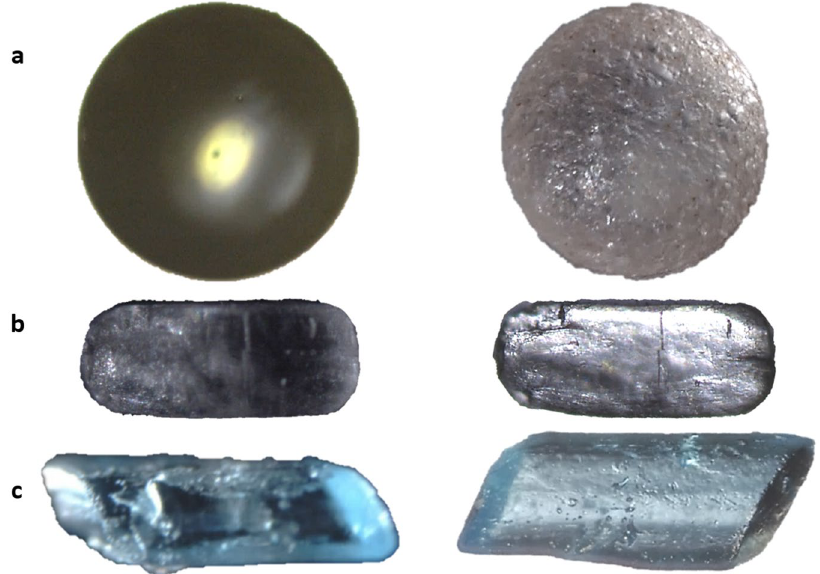
Figure 3. Imaging comparison between traditional microscopy and optimized optics. Traditional microscopy (left) does not have the illumination and setup optimized in respect of the optical activity of particles, compared to our method (right), which focuses on optimized background environment, and an innovative microscope objective combined with a specific illumination that permit the particle to self-distribute the light rays internally for better surface observation, rather than acting as a prism with uniform reflections. ( a ) A semi-transparent soda-lime glass sphere (700 µ m). ( b ) An acetylsalicylic acid crystal (560 µ m). ( c ) Different copper sulfate crystals (850 µ m (left) and 950 µ m (right)). Images of a, right, and c, right, were built based on focus-stacking. The other images are single snapshots. Images (to the right) were taken using the setup in Fig. 1, middle, with white